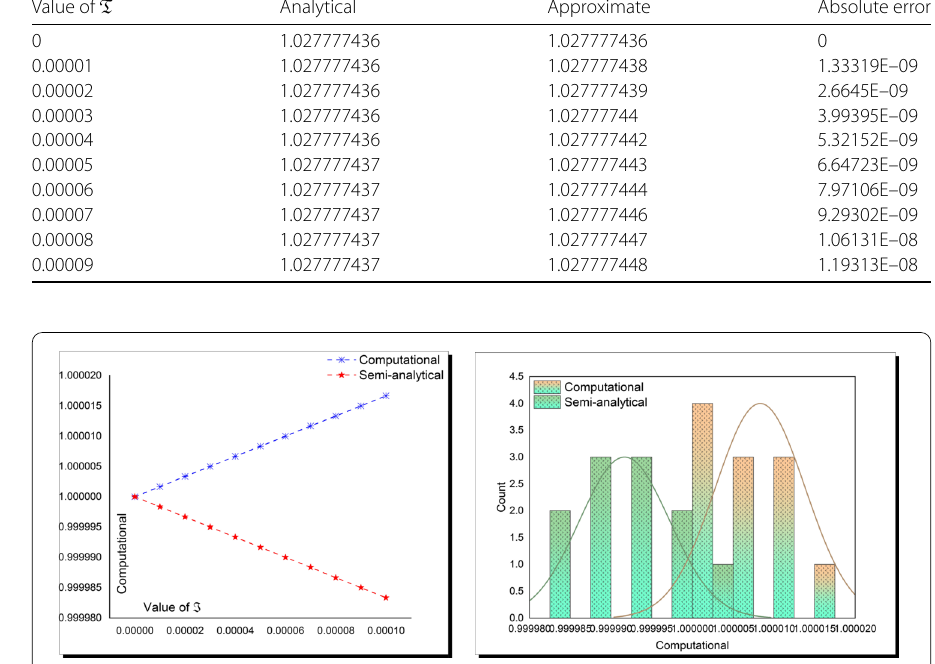
Figure 1 Two-dimensional sketches between the analytical and approximate solutions based on the AD method for illustrating the matching between solutions